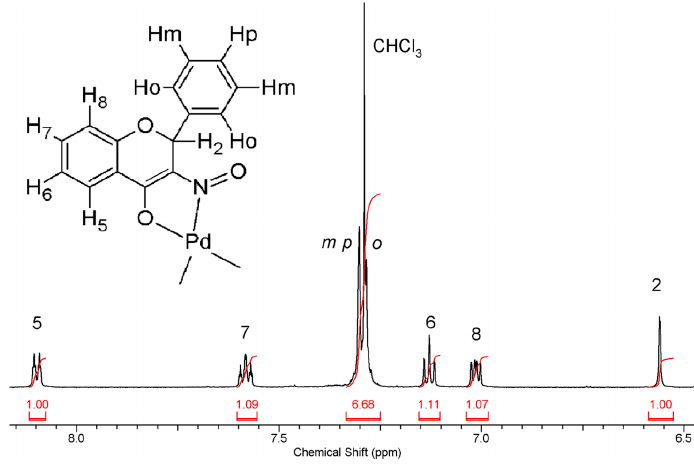
Figure 5. 1 H-NMR spectrum of 2 in CDCl 3 , with integration values and assignments.